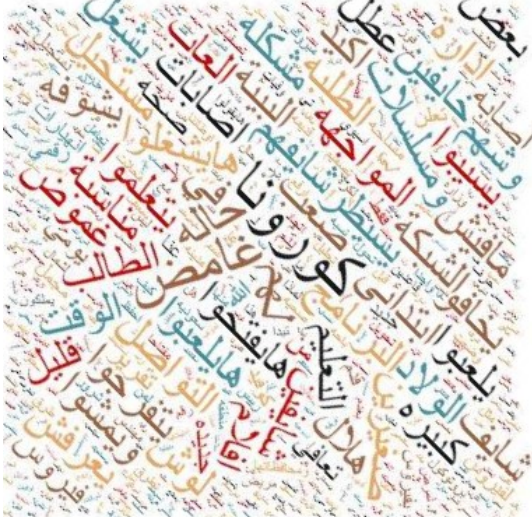
Figure 9: An instance of word cloud for negative